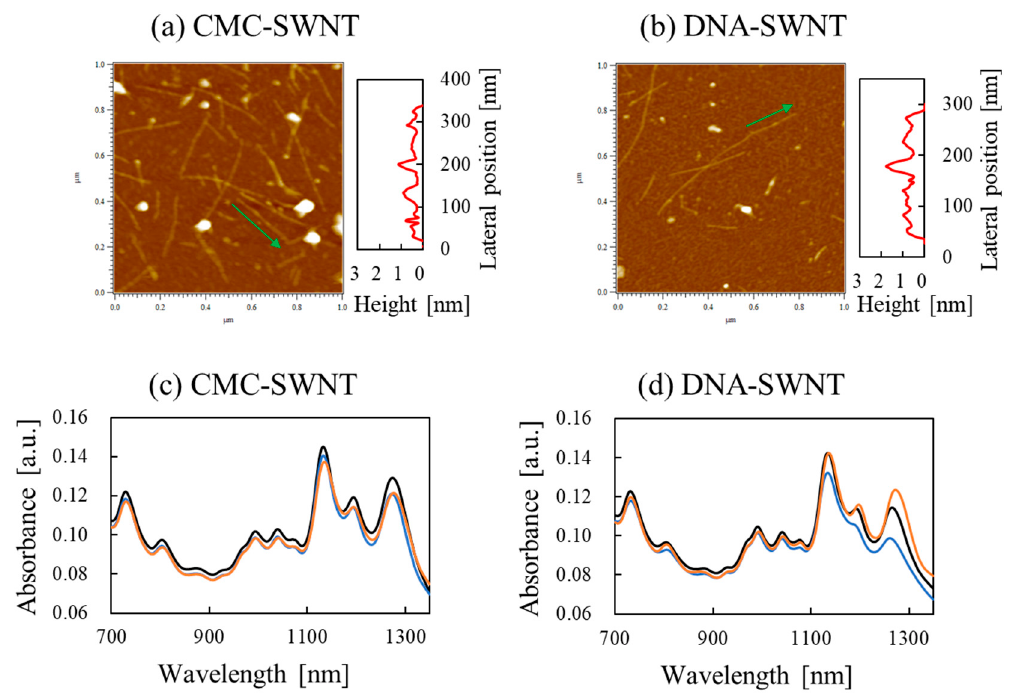
Figure 3. AFM images: ( a ) CMC–SWNTs, ( b ) dsDNA–SWNTs. NIR absorption spectra of SWNT composites: ( c ) CMC–SWNTs, ( d ) dsDNA–SWNTs. Black line: SWNT composites initially prior to adding H 2 O 2 . Blue line: SWNT composites oxidized with 0.03% H 2 O 2 solution for 30 min. Orange line: the oxidized SWNT composites were incubated with 15 µ g / mL catechin solution for 10 min. The absorption values represent the average of five independent measurements. The results of Figure 3 were measured by co-author R.